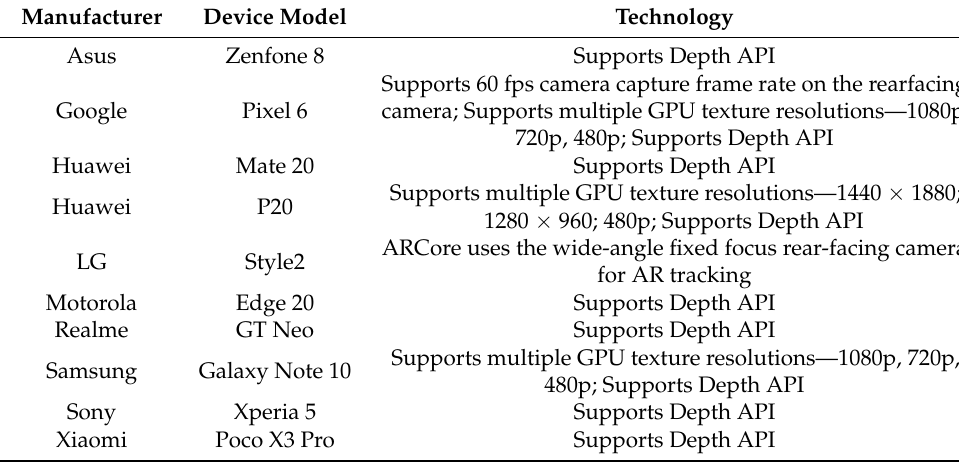
Table 2. Example of supported Android devices [22].